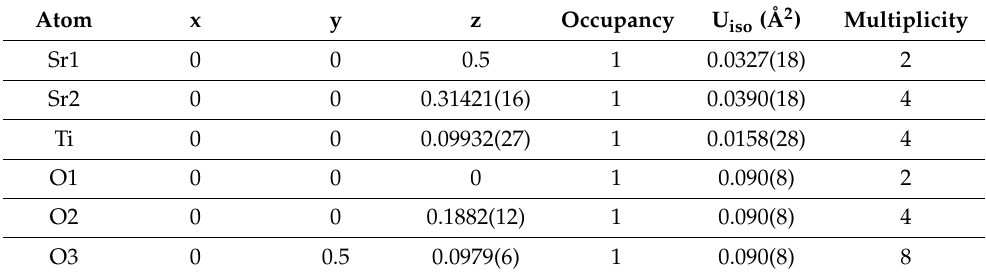
Table 1. Refined structural parameters of Sr 3 Ti 2 O 7 from powder X-ray diffraction data. Space group: